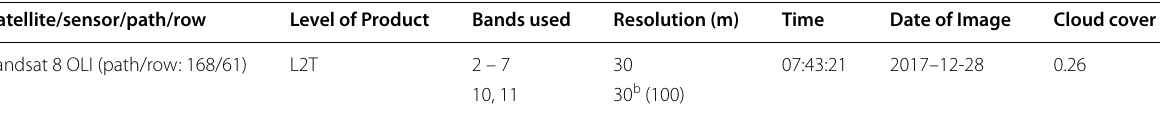
Table 2 Details of Landsat bands used in radiometric correction Satellite/sensor/path/row Level of Product Bands used Resolution (m) Landsat 8 OLI (path/row: